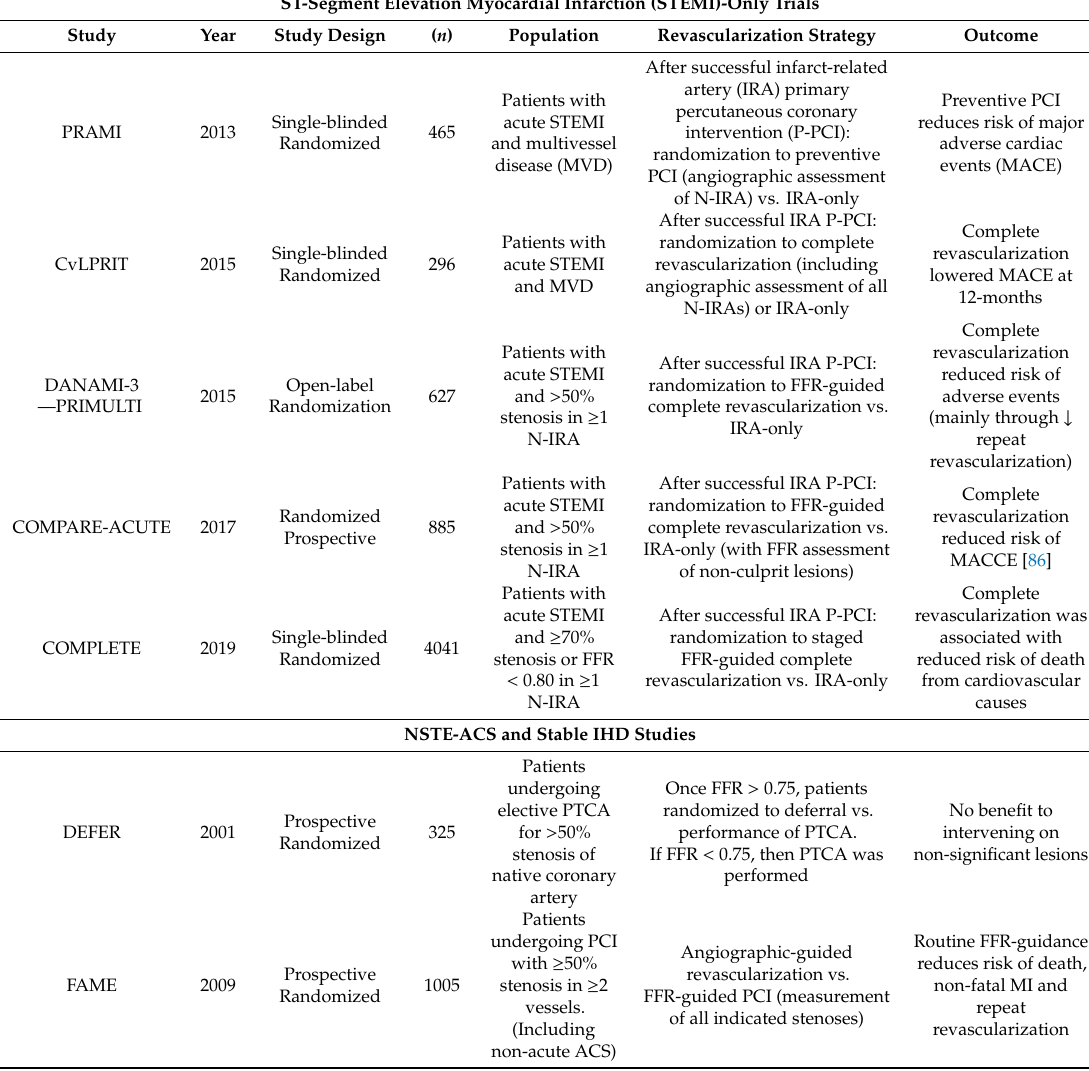
Table 2. Summary of Landmark Studies using fractional flow reserve (FFR) in Acute Coronary Syndrome / Stable Ischemic Heart